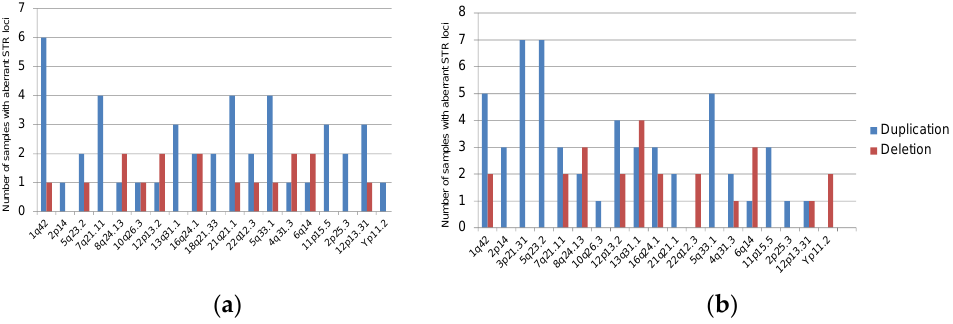
Figure 3. Occurrence of duplication and deletion (or copy number neutral LOH) in plasma ctDNA ( a ) and in CD138+ bone marrow cells ( b ).